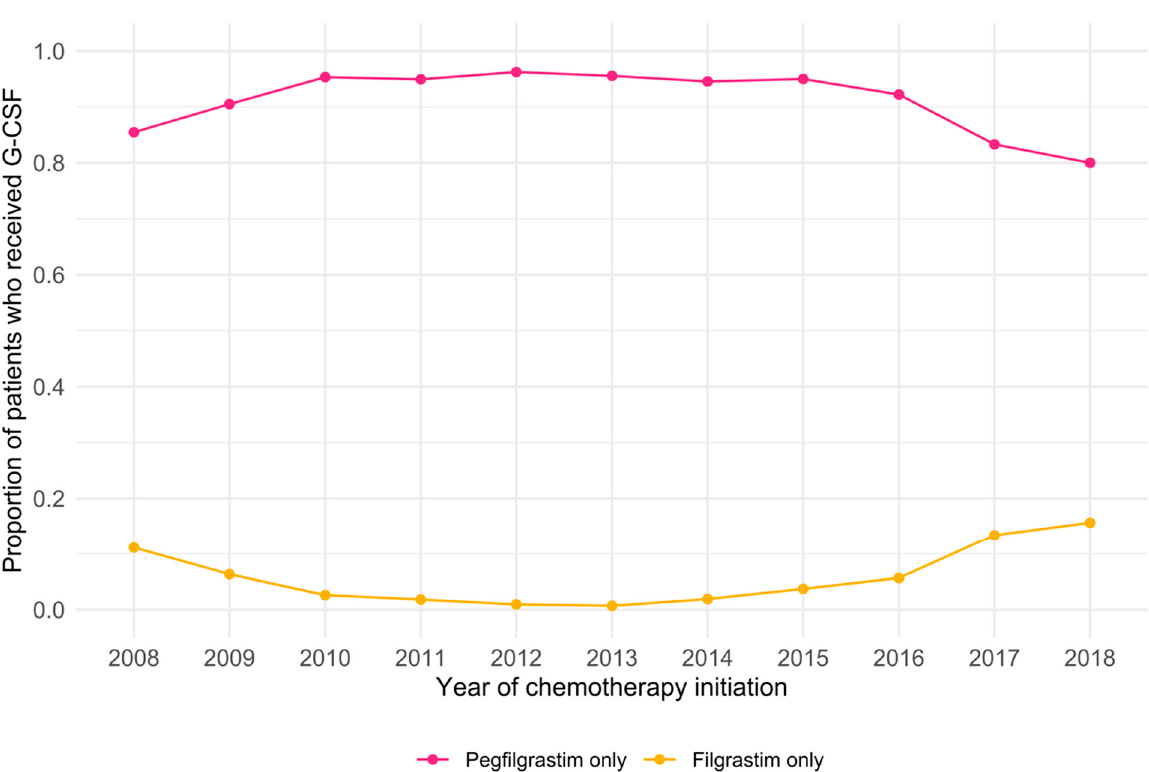
Figure 2. Trends in G-CSF usage by calendar year among patients who received G-CSF, stratified by G-CSF type.